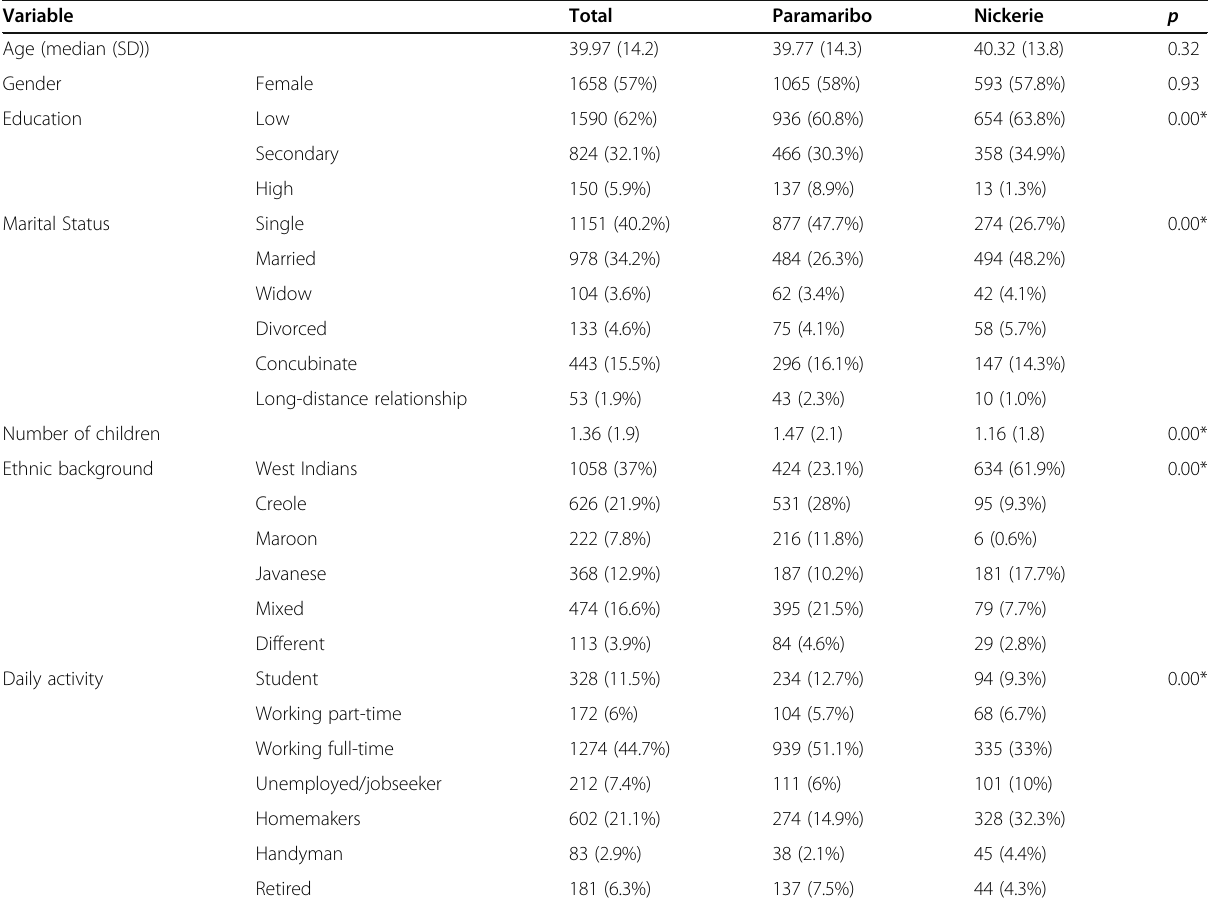
Table 1 Demographics of the Paramaribo and Nickerie